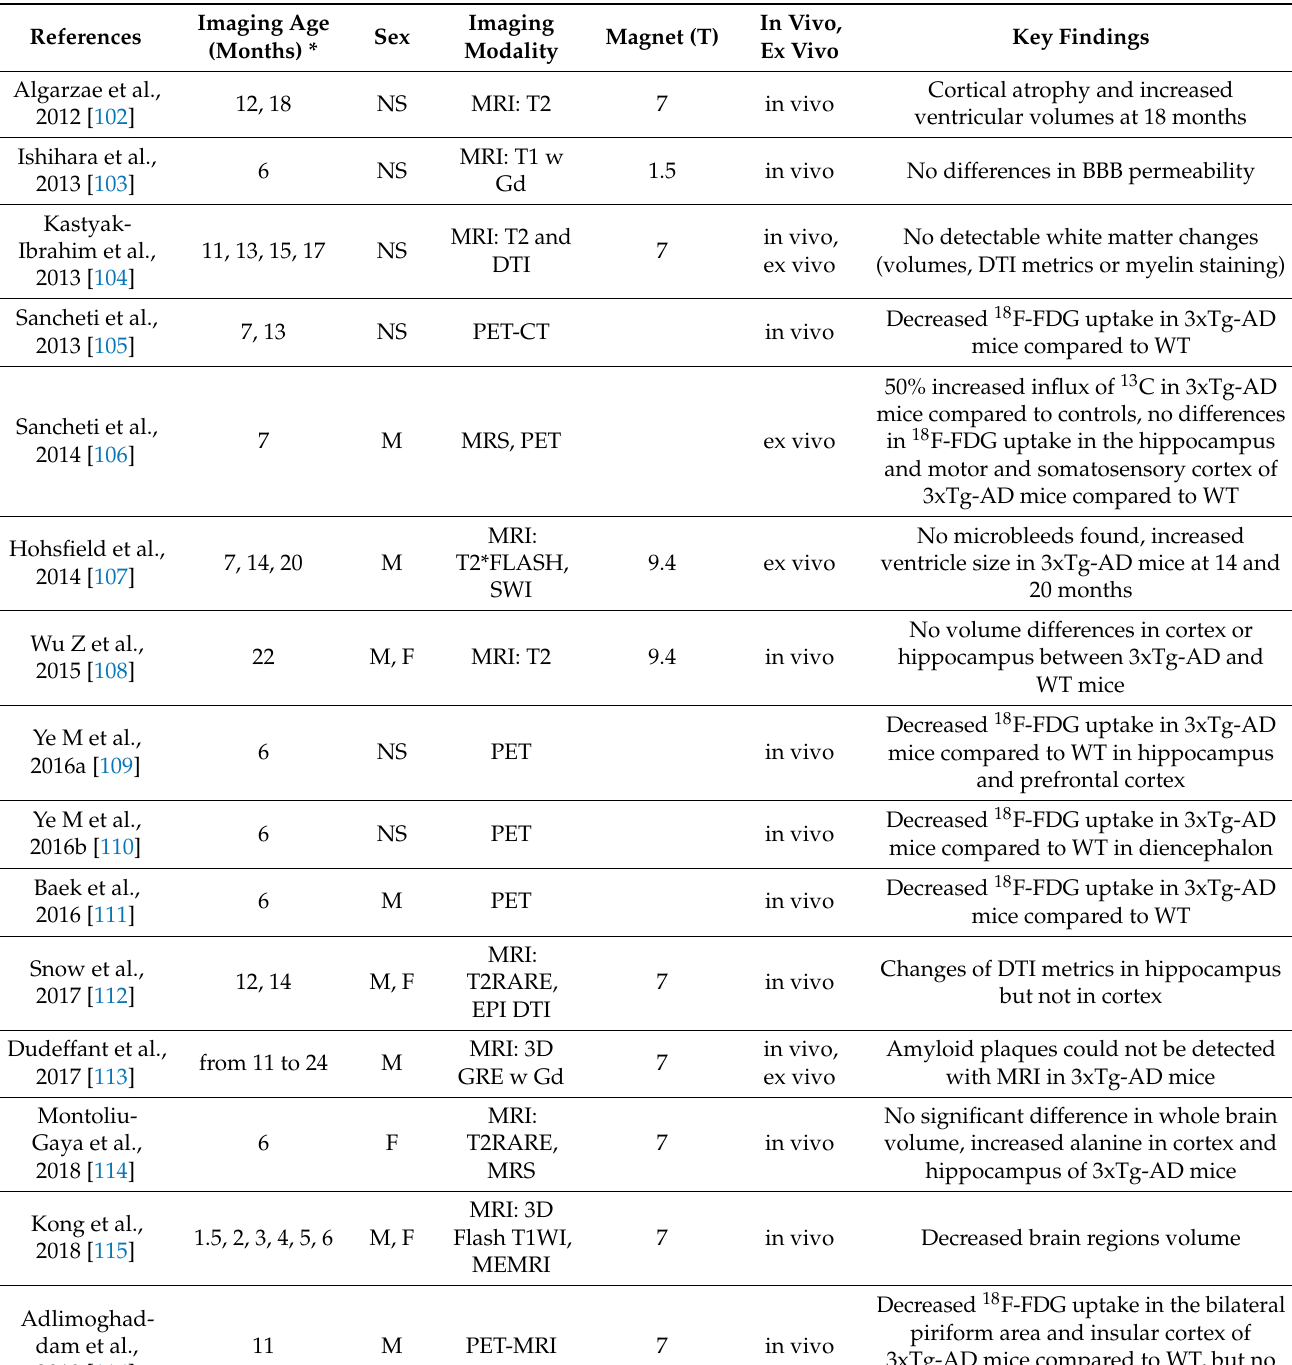
Table 3. Summary of 3xTg-AD mice